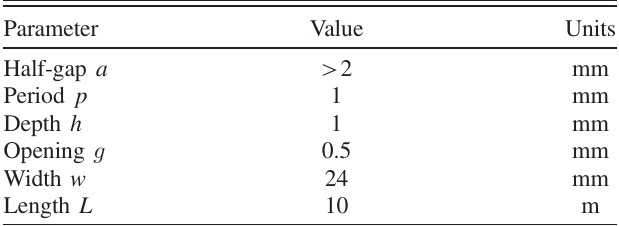
TABLE III. Parameters of the corrugated